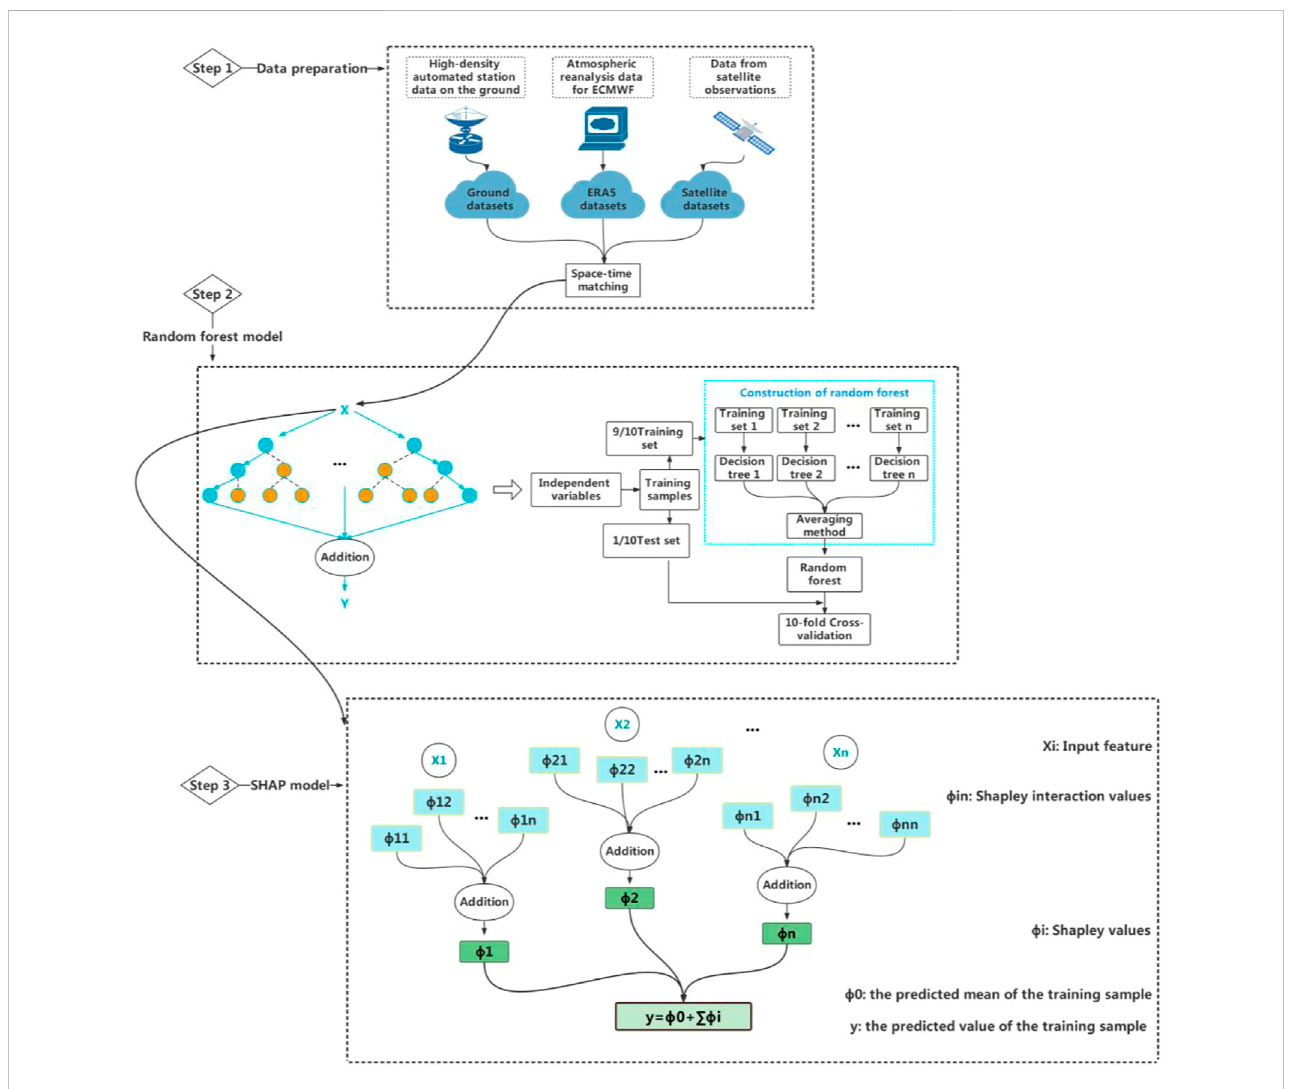
FIGURE 2 Research